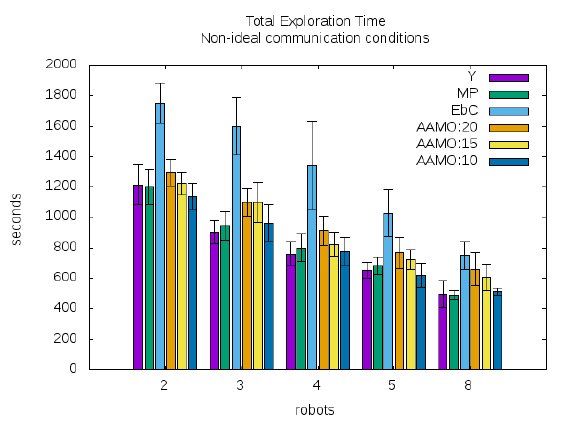
Figure 23. Total Exploration Time (TT) under non-ideal communication